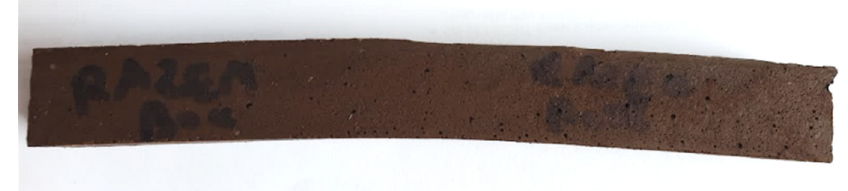
Figure 10. The view of pores of glass wool-based geopolymer mortar with bauxite.